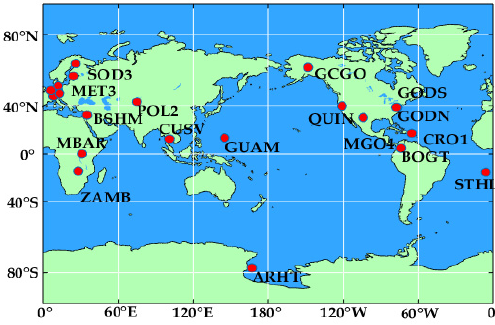
Figure 1. Distribution of the 23 selected IGS MGEX stations.